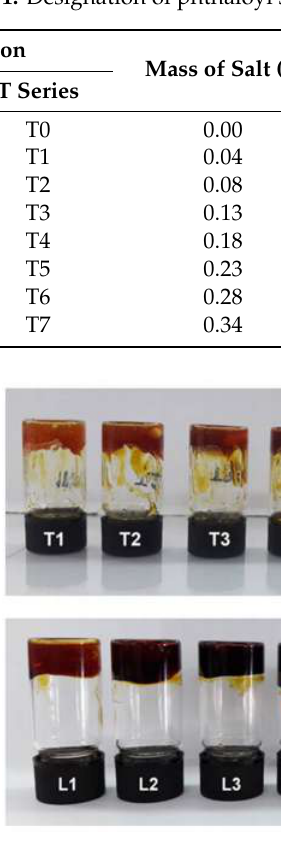
Table 1. Designation of phthaloyl starch and the HEC based electrolyte.